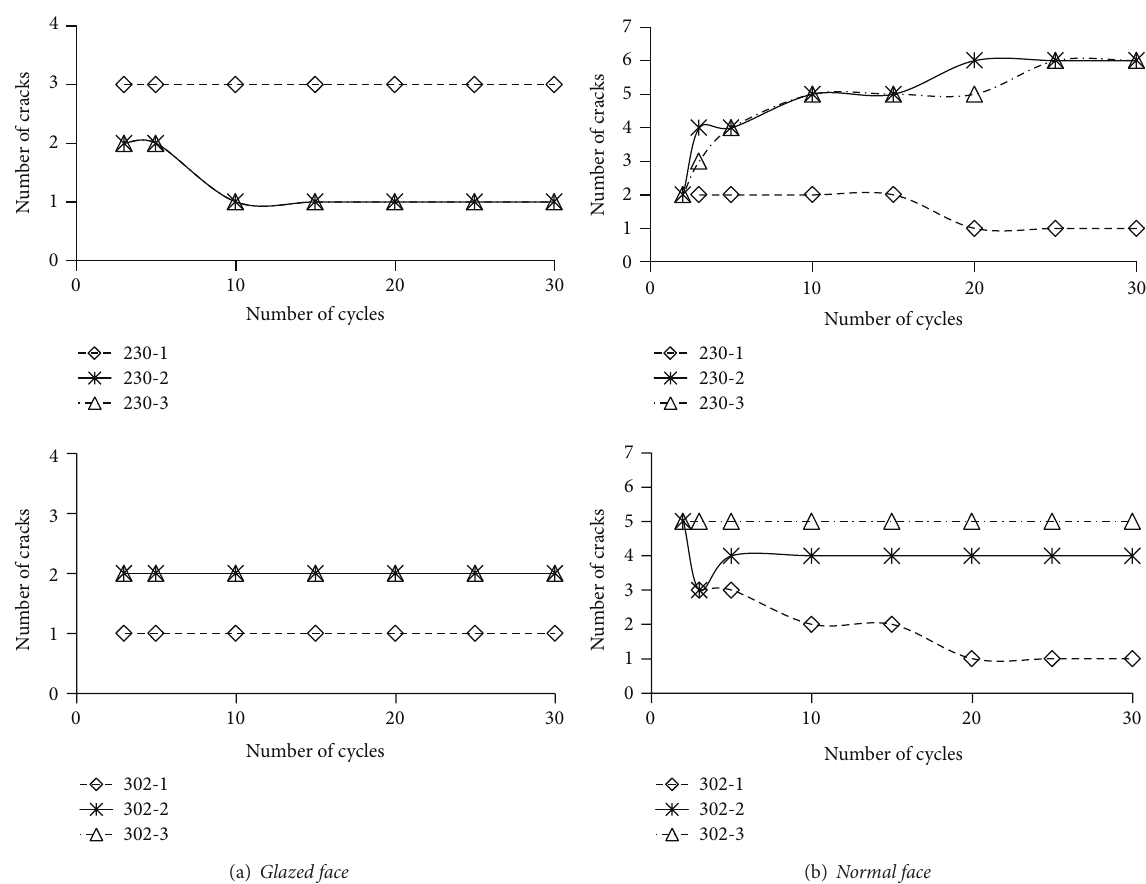
Figure 4: Number of cracks as a function of the number of thermal shock cycles at Δ𝑇 = 23 0 ∘